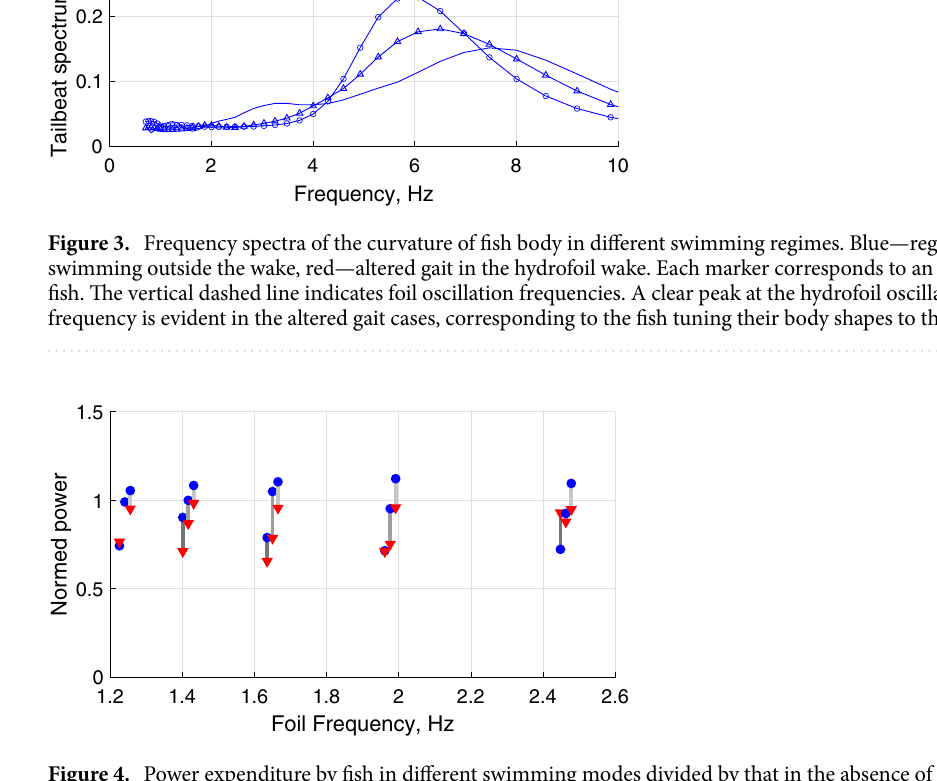
Figure 4. Power expenditure by fish in different swimming modes divided by that in the absence of the vortex street: blue circles—regular swimming outside the wake, red triangles—altered gait in hydrofoil wake. Pairs corresponding to the same fish are joined by grey lines and shifted horizontally to improve clarity. A consistent reduction of the energy expenditure can be observed for all three fish at the foil frequencies of 1.4 Hz, 1.6 Hz and 2.0